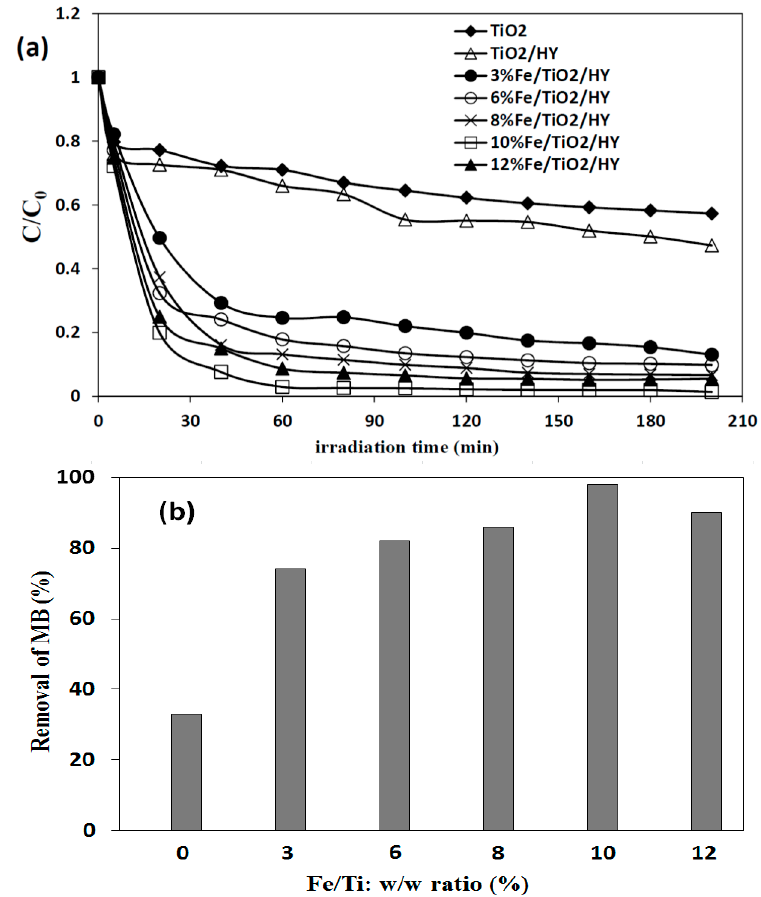
Figure 8. Photocatalytic degradation of MB solution catalyzed by undoped TiO 2 /HY and doped TiO 2 /HY with different amounts of iron dopant. Tests were run under visible light irradiation. ( a ) Photocatalytic degradation rate vs. irradiation time; and ( b ) the influence of the ion dopant on dye removal (time = 60 min). Experimental conditions: dye concentration = 20 mg L − 1 , catalyst amount = 1 g L − 1 , T = 25 °C.